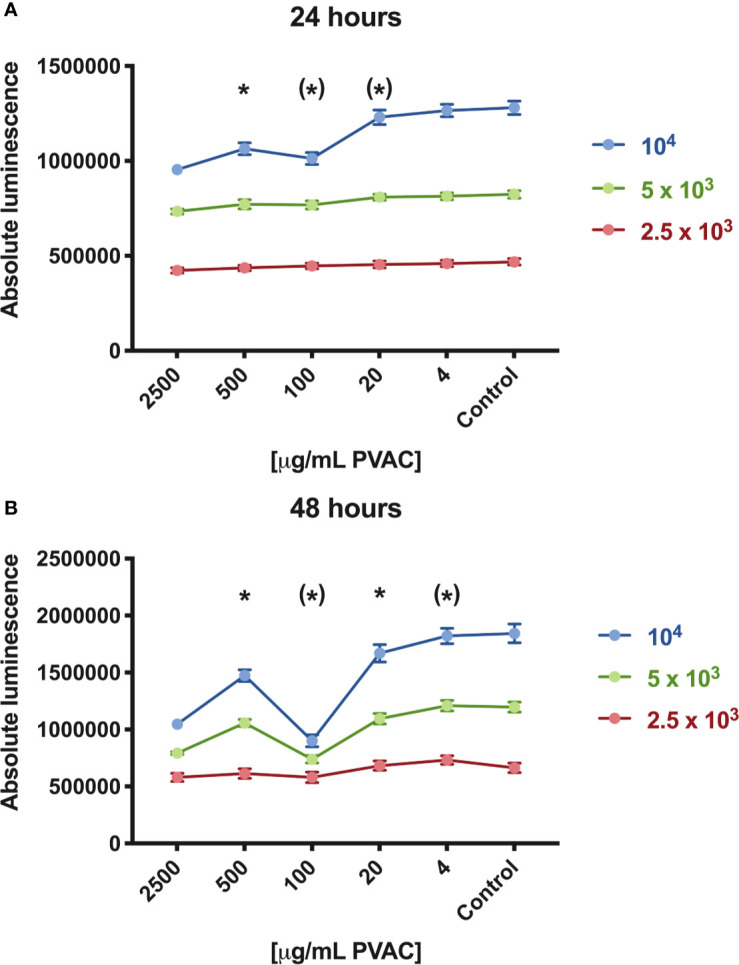
Cell viability of GIST-T1 cells cultured in the presence of polyvinyl alcohol carbazate (PVAC) at varying seeding densities [2,500 (low), 5,000 (medium), and 10,000 (high) cells/well, respectively]. (A) At 24 h concentrations of 100–2,500 µg/ml reduced viability in high seeding density, whereas in 2,500 µg/ml in medium seeding density. (B) After 48 h 20–2,500 µg/ml reduced viability in high seeding density, and 2,500 and 100 µg/ml in medium seeding density. No significant decrease in cell viability was observed in low seeding density. n = 3 (biological replicates). * denotes p-value < 0.05.